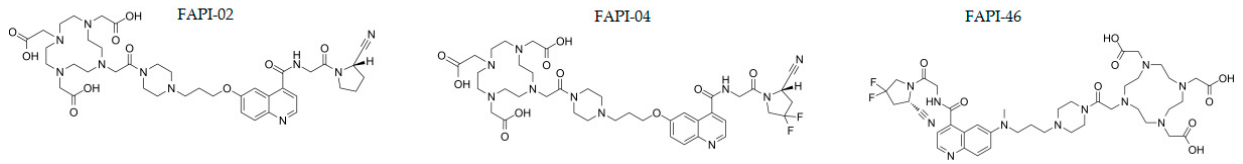
Figure 1. Chemical structure of FAPI subtypes used in clinical practice [11].